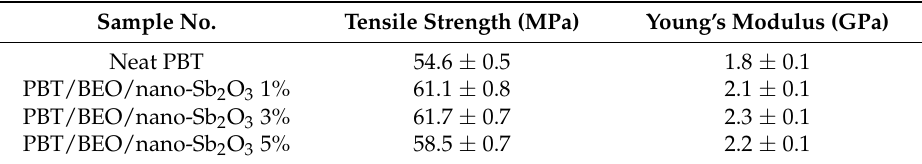
Table 3. Mechanical properties of the neat PBT and of its nanocomposites. Sample